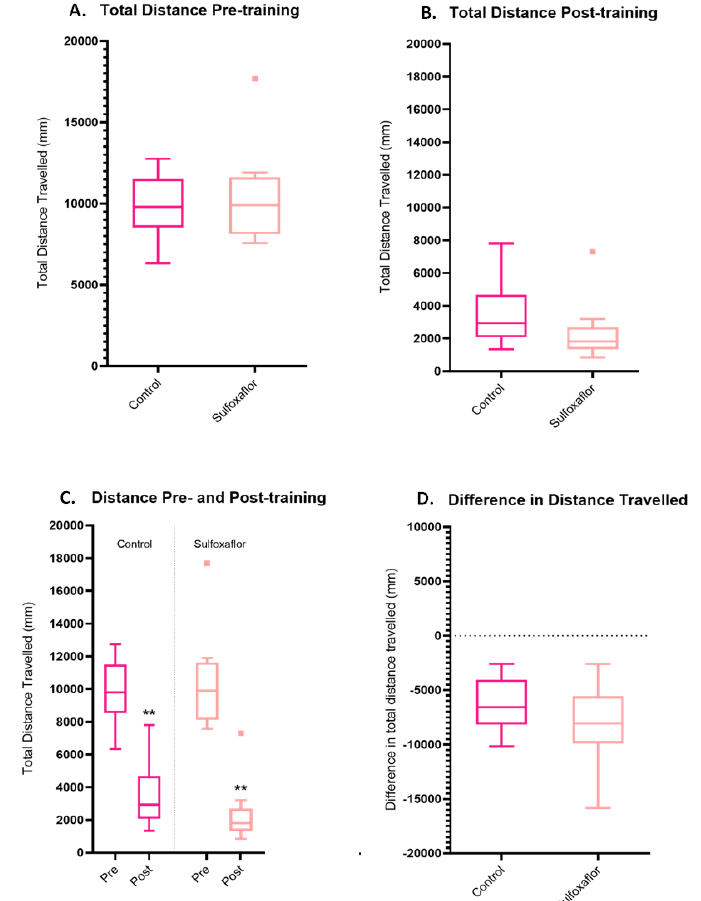
Figure 8. Total distance travelled pre- and post-training by bees in the high concentration trials. ( A ) Total distance travelled pre-training. p values > 0.7, Kruskal–Wallis test. ( B ) Total distance travelled post-training. Control vs. sulfoxaflor p = 0.93, Kruskal–Wallis test. ( C ) Total distance travelled pre- versus post-training. Control p = 0.0039 **, sulfoxaflor p = 0.0039 **. ( D ) Difference in distance travelled (post-training − pre-training value). Control n = 9, sulfoxaflor n = 9. Coloured squares ( (cid:4) ) represent individual bee outlier data.